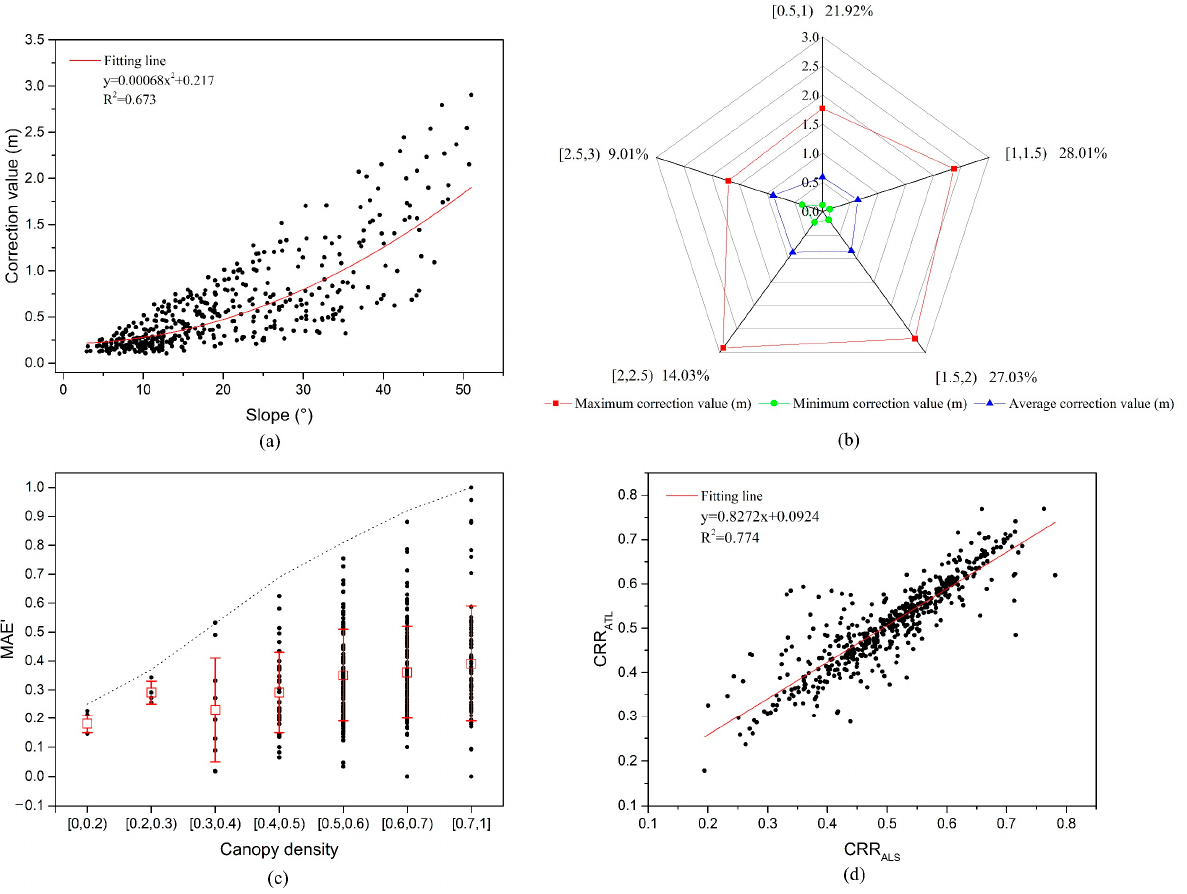
Figure 11. Analysis of influencing factors of ICESat–2 canopy height inversion: ( a ) effect of slope on the corrected canopy height; ( b ) effect of Dd on the corrected canopy height; ( c ) MAE for different canopy densities; ( d ) scatterplot of the CRR obtained from CAF–LiCHy and ICESat–2 data.